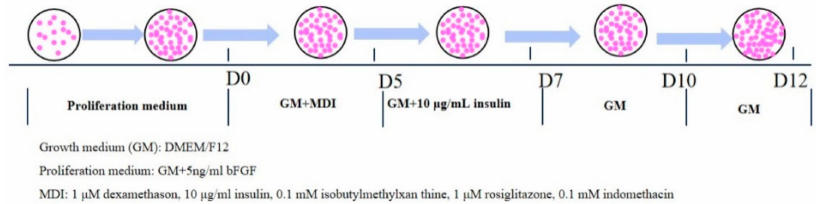
Figure 1. The time flow diagram for inducing ADSC to differentiate into mature